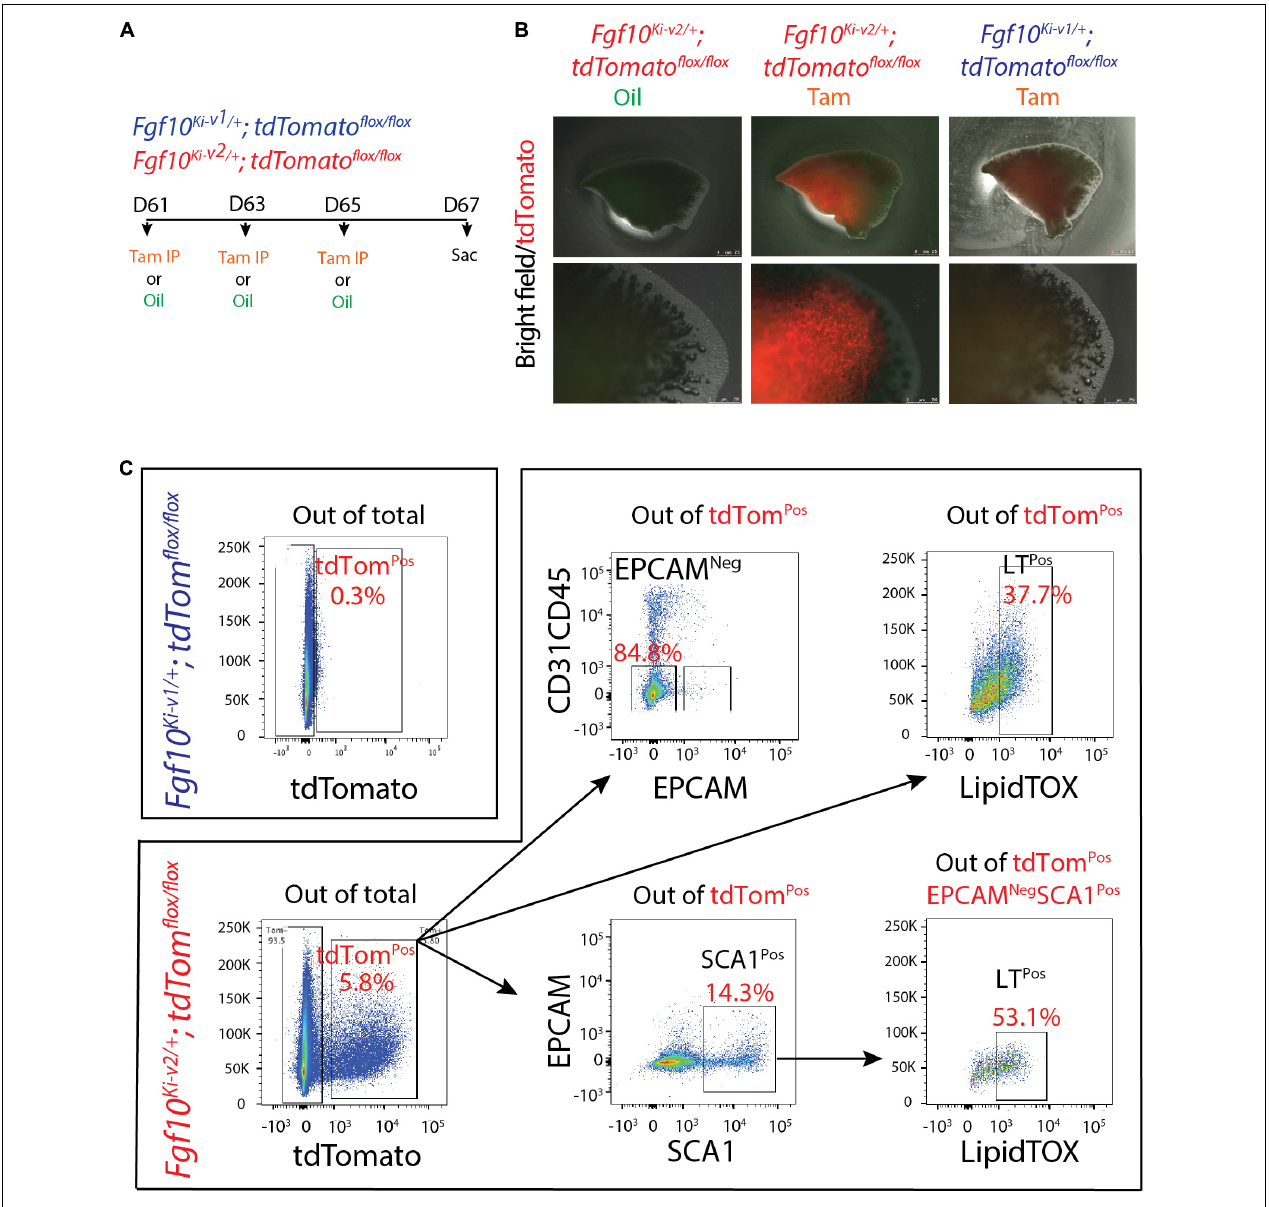
FIGURE 6 | Fgf10 Ki - v 2 / + ; tdTom flox / + adult lungs display enhanced number of tdTom Pos cells compared with to the Fgf10 Ki - v 1 / + ; tdTom flox / + adult lungs. (A) 2-months-old; Fgf10 Ki - v 1 / + ; tdTom flox / + and Fgf10 Ki - v 2 / + ; tdTom flox / + mice received 3 Tam IPs or oil at P61, P63 and P65 and were sacrificed at P67. (B) Whole-mount fluorescence images of oil-treated Fgf10 Ki - v 2 / + ; tdTom flox / + , Tam-treated Fgf10 Ki - v 2 / + ; tdTom flox / + and Tam-treated Fgf10 Ki - v 1 / + ; tdTom flox / + lungs at P67. Higher magnification of the lungs are shown in the lower panel. (C) Flow cytometry analysis of Fgf10 Ki - v 2 / + ; tdTom flox / flox lung homogenate. Scale bar in (B) : low magnification: 2.5 mm, High magnification: 0.75 mm.